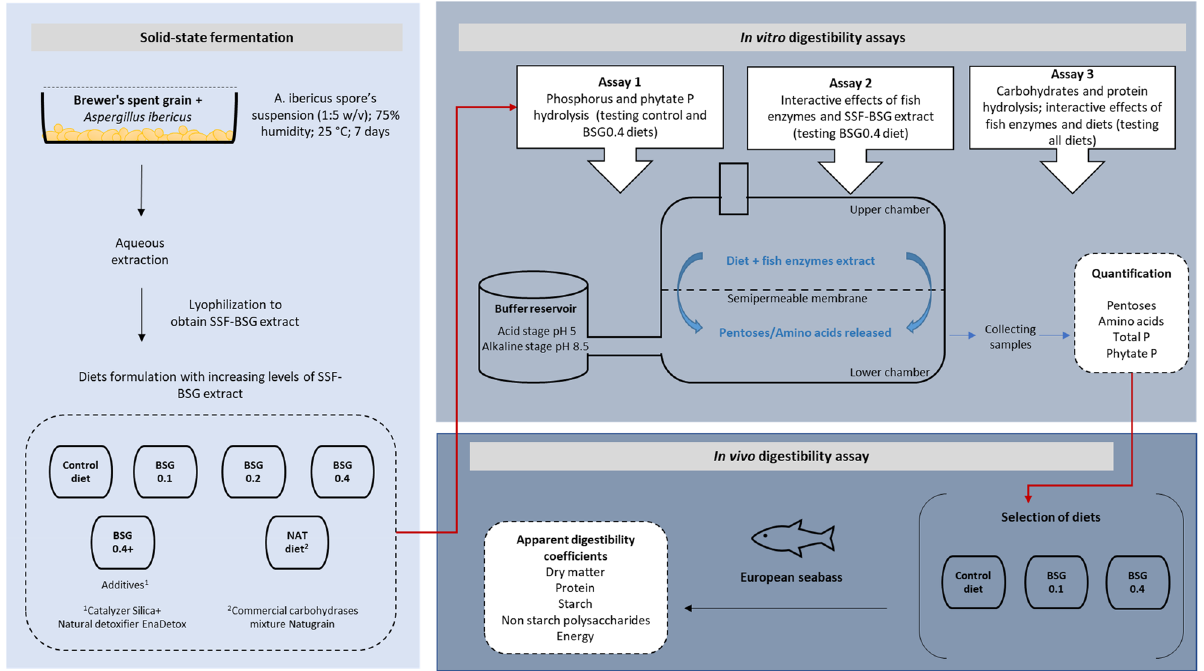
Figure 1. Flow chart of the experimental